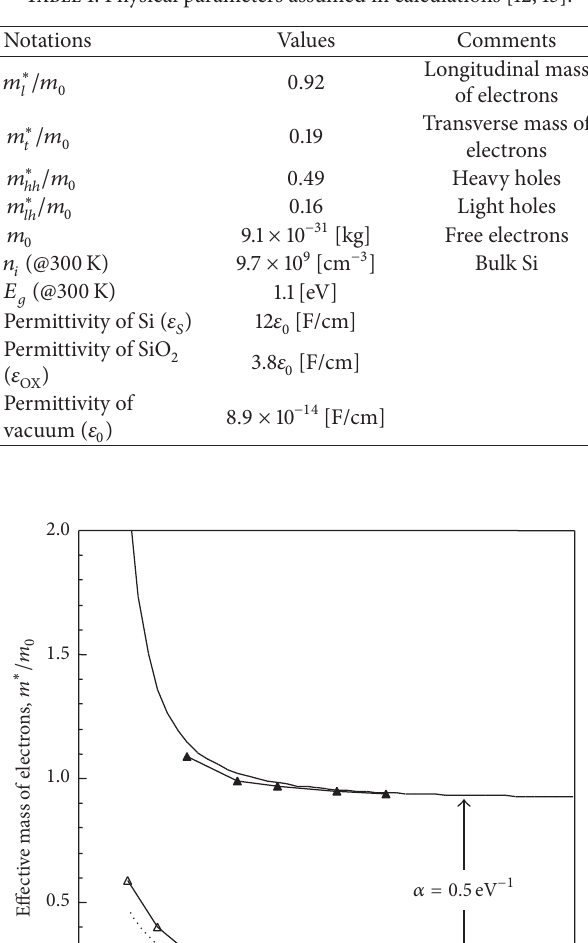
Table 1: Physical parameters assumed in calculations [12, 13].